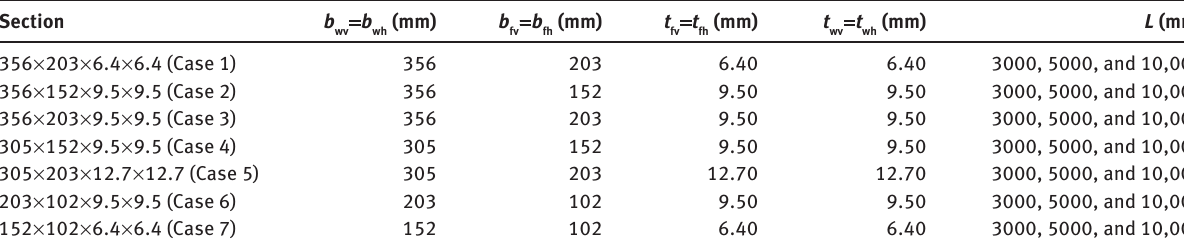
Table 2 Geometrical dimensions of stiffened cruciform-shaped section